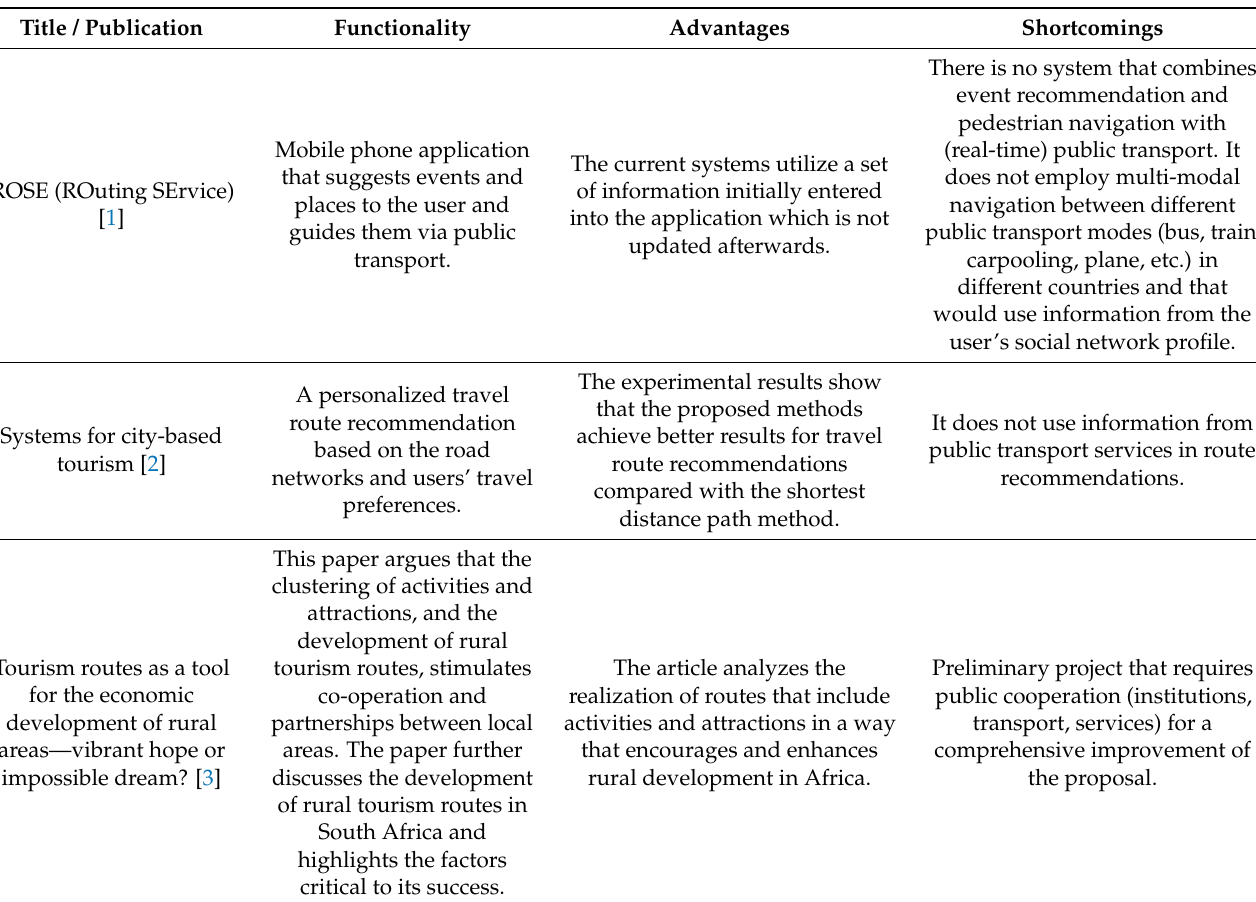
Table 1. Review of similar works: Part